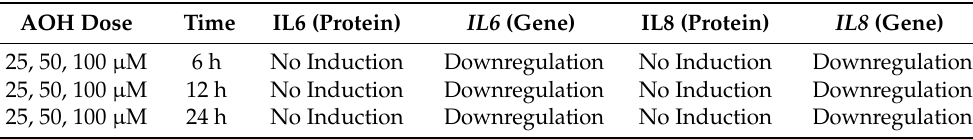
Table A1. Summary of alternariol (AOH) dosage and treatment conditions for BEAS-2B cells. No IL6 and IL8 protein level production was observed. IL6 and IL8 mRNAs were found to be downregulated upon stimulation with AOH in BEAS-2B cells.